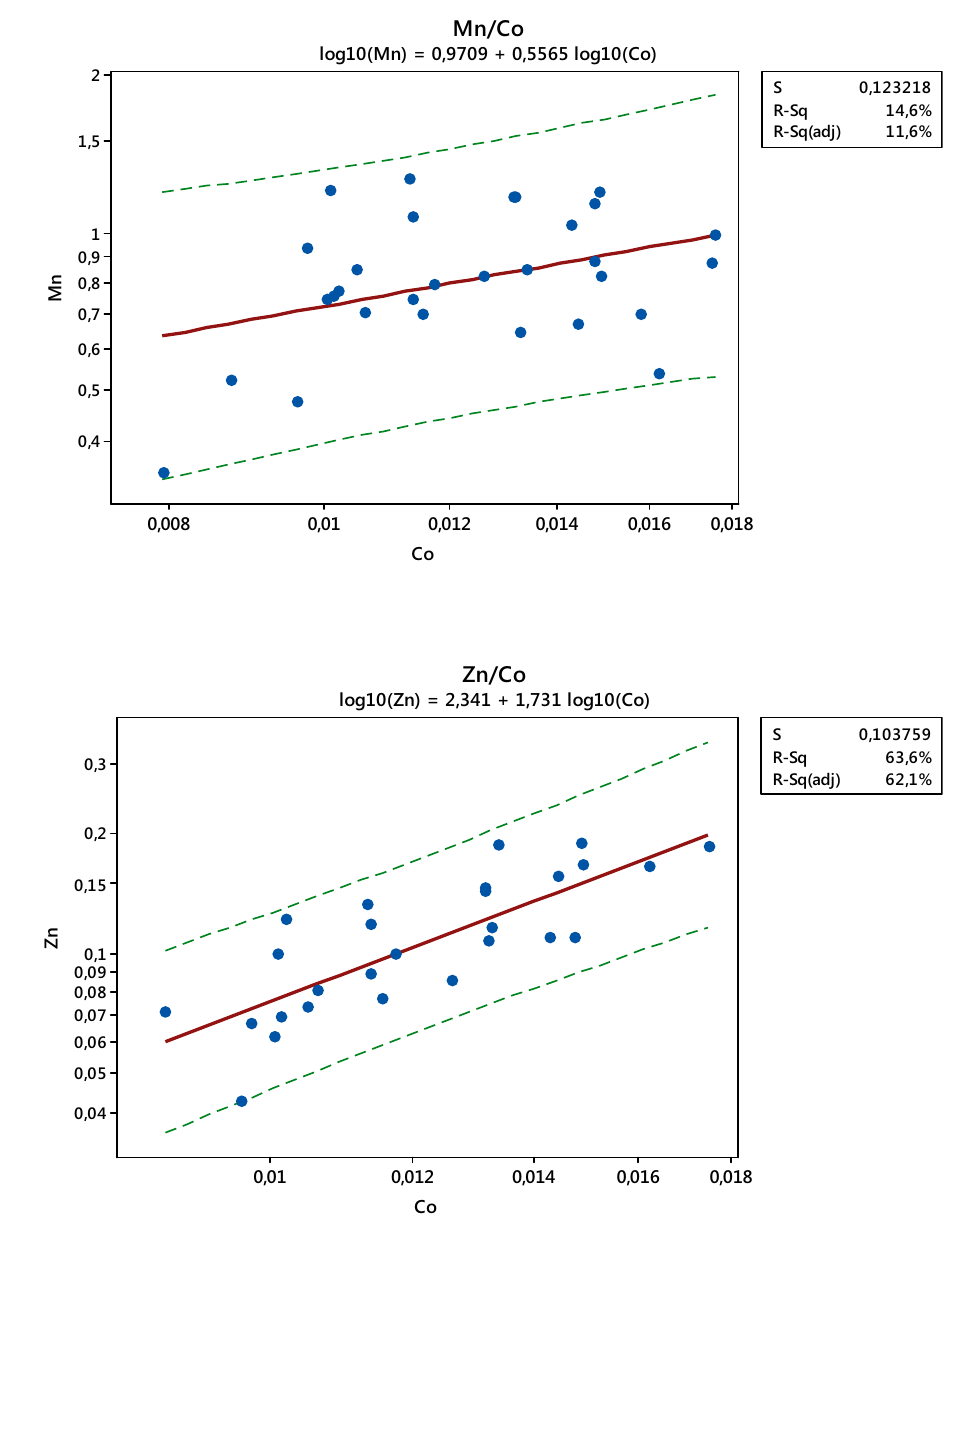
Fig. 8 Linear regression graph of manganese background concentration determination ( R 2 = 14.6%)